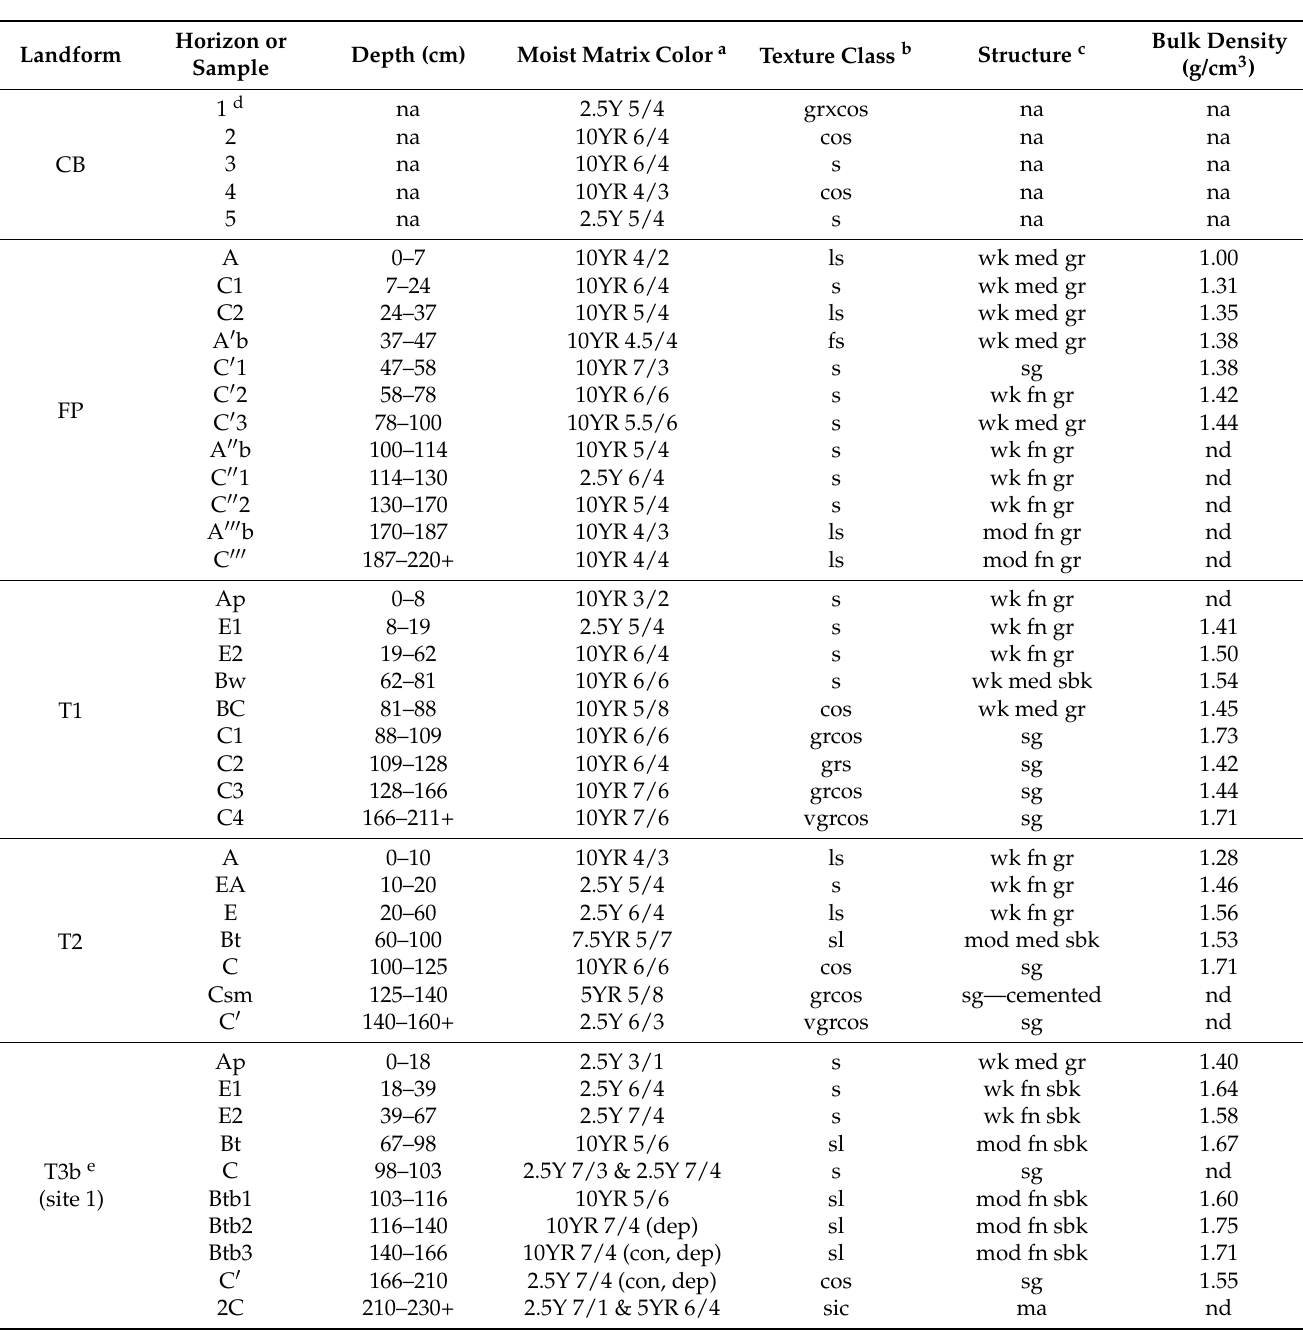
Table 2. Abbreviated morphological descriptions for soils at sampling pits, adapted from Table 2 of Suther and Leigh [33] and Table 3 of Suther et al. [29]. Color and textural characteristics of modern channel bed sediment are also